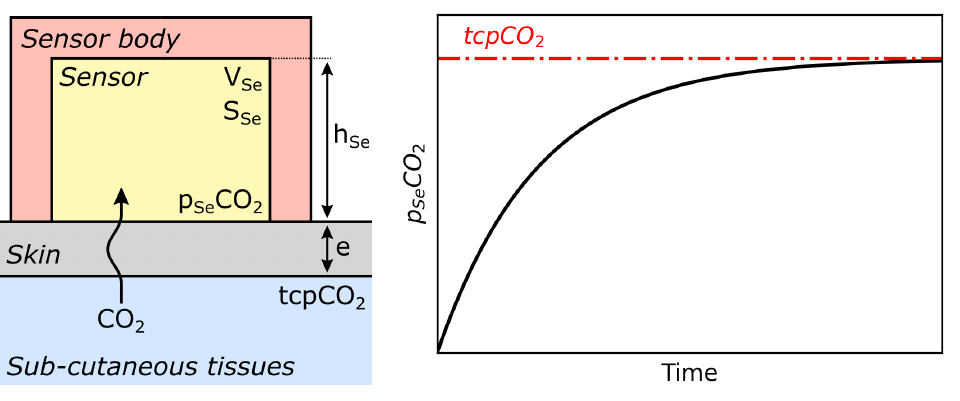
Figure 14. ( Left ) crude closed-chamber sensor model. Please note the colour matching between this schematic and previous Figures—e.g., Figures 4–7—blue for the analyte medium, yellow for the sensor itself. ( Right ) typical evolution of p Se CO 2 against time when applying the sensor against the